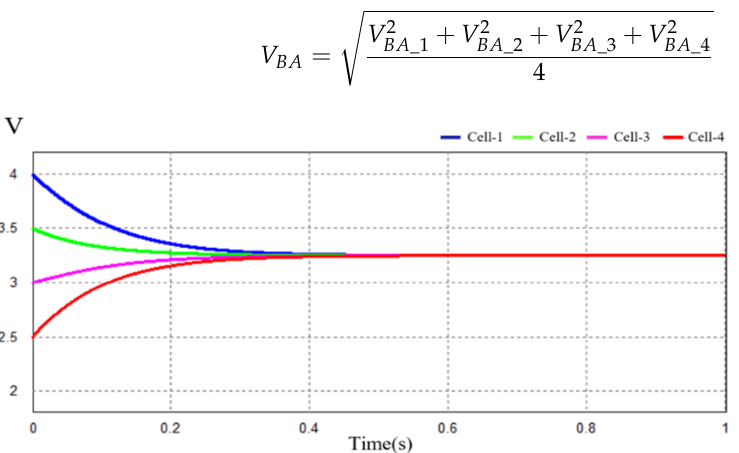
Figure 12. Battery cell voltage.